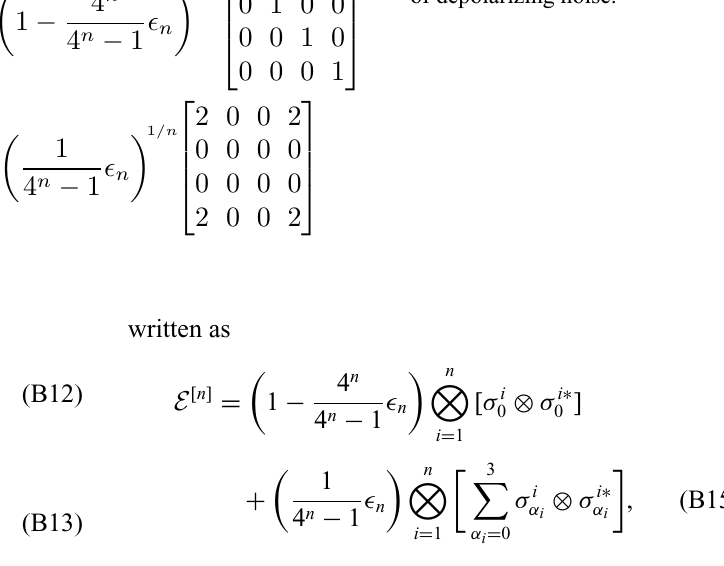
FIG. 11. Nonzero tensor ele- ments in the MPO representation of depolarizing noise.